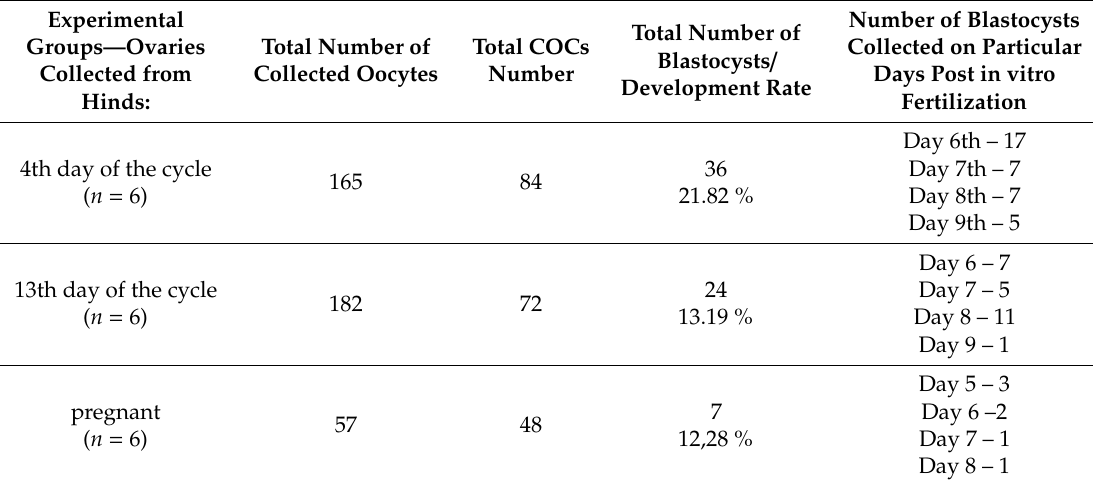
Table 2. Number of collected oocytes, cumulus-oocyte complexes (COCs), and blastocysts on particular days post in vitro fertilization and embryo development rate. Di ff erent letters indicate statistical di ff erences in hormone concentrations on the 4th day versus the 13th day of the estrous cycle versus during pregnancy in cleavage and developmental rates. p < 0.05 was considered significant.